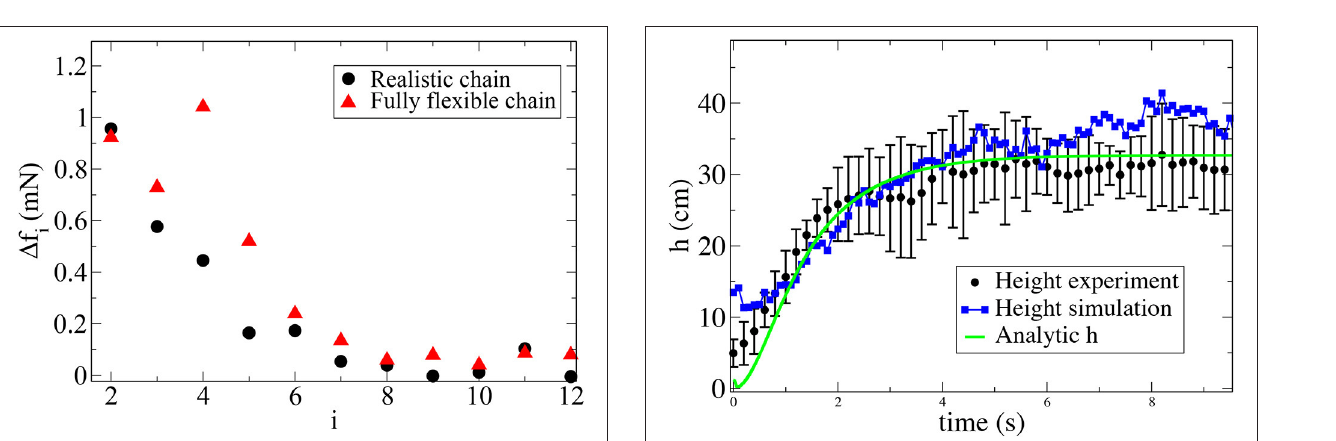
FIGURE 5 | The time-averaged force 1 f i from the container on the realistic FIGURE 6 | The fountain height obtained from an average of 8 experiments and flexible chain as a function of bead number. Here i 1 labels the last bead and a simulation with h 1 2.4 m along with a semi-analytic prediction derived = = to interact with the bottom, i 2 labels the second last bead to interact with from Equations (11) and (12) in Biggins [4] using α = = the bottom etc. The i 1, values are 1 f 1 64 and 72 mN for the flexible and = = realistic chains respectively and are way outside the range of the i 2 values ≥ which are shown for here.